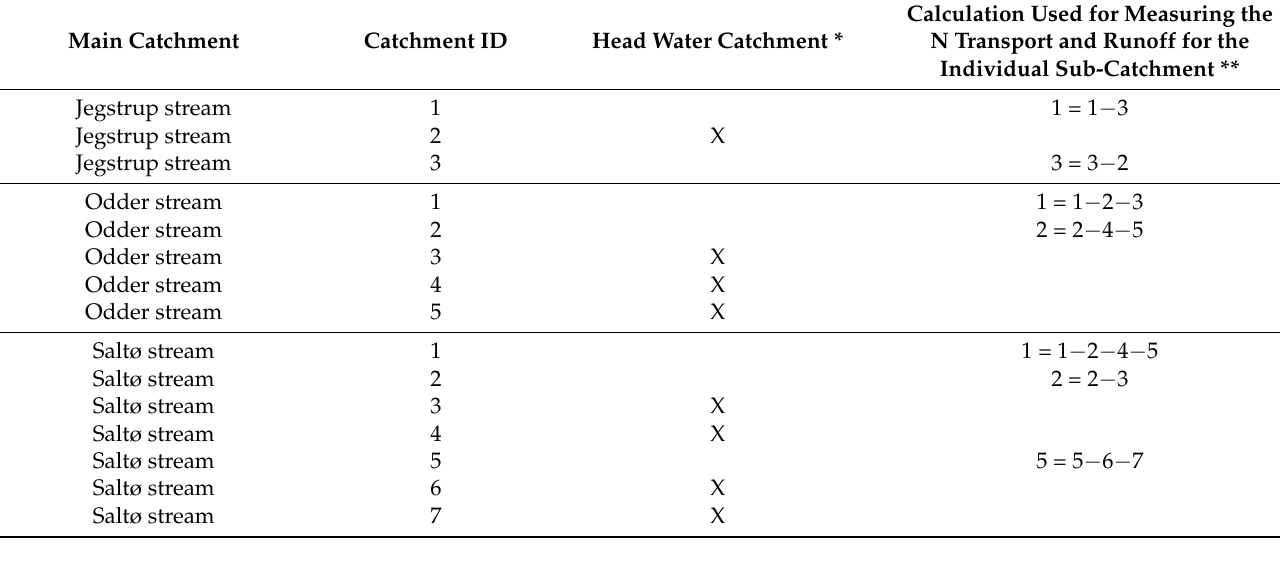
Table A2. Table showing the delimitation of the main Jegstrup, Odder, and Saltø catchments into sub-catchments and the principle of the mass balance calculation when calculating the runoff and N transport for the individual sub-catchments. * By Head Water Catchment indication we mean that this sub-catchment was not affected by upstream sub-catchments. ** In the calculation, only the measurements at the main and synchronous stations were used for estimation of the runoff and N transport. Calculation Used for Measuring the N Transport